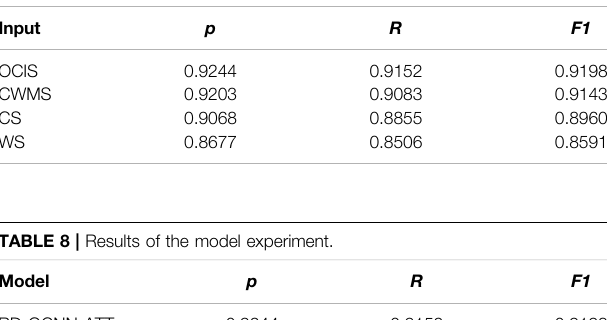
TABLE 7 | Input sequence experimental results.